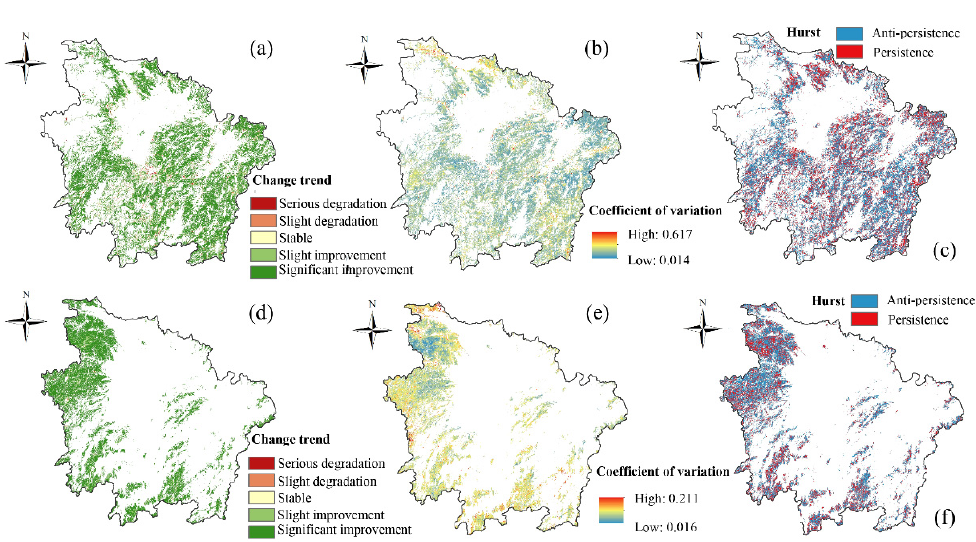
Figure 6. Distribution and variation of NDVI in plantations ( a – c ) and natural forests ( d – f ) in the